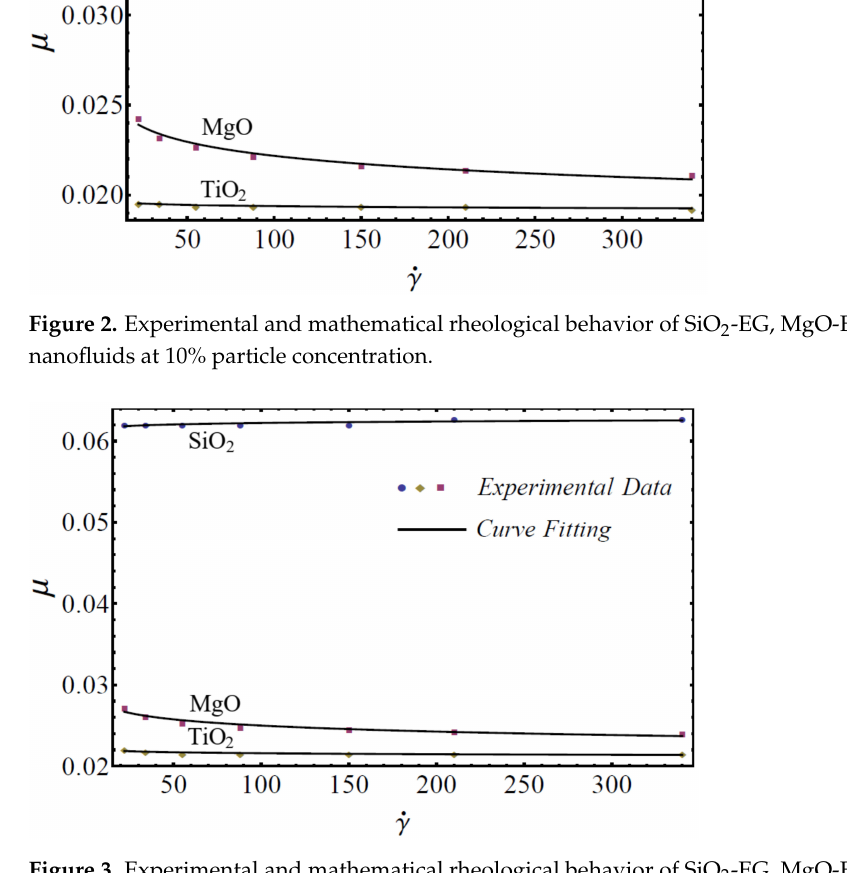
Figure 3. Experimental and mathematical rheological behavior of SiO 2 -EG, MgO-EG, and TiO 2 -EG nanofluids at 15% particle